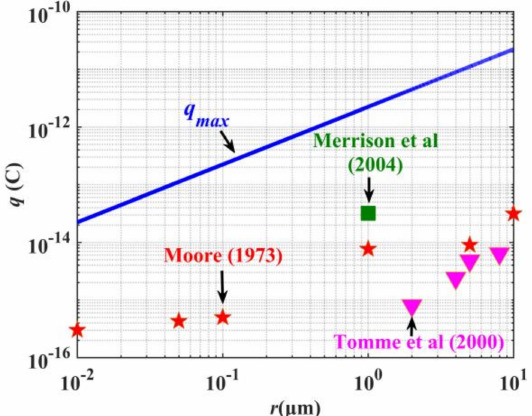
Figure 2. The dependence of the particle’s saturation charge q max on the particle radius. Here, it is assumed that the breakdown surface potential is 20 kV. The scatters are reported experimental data from refs.